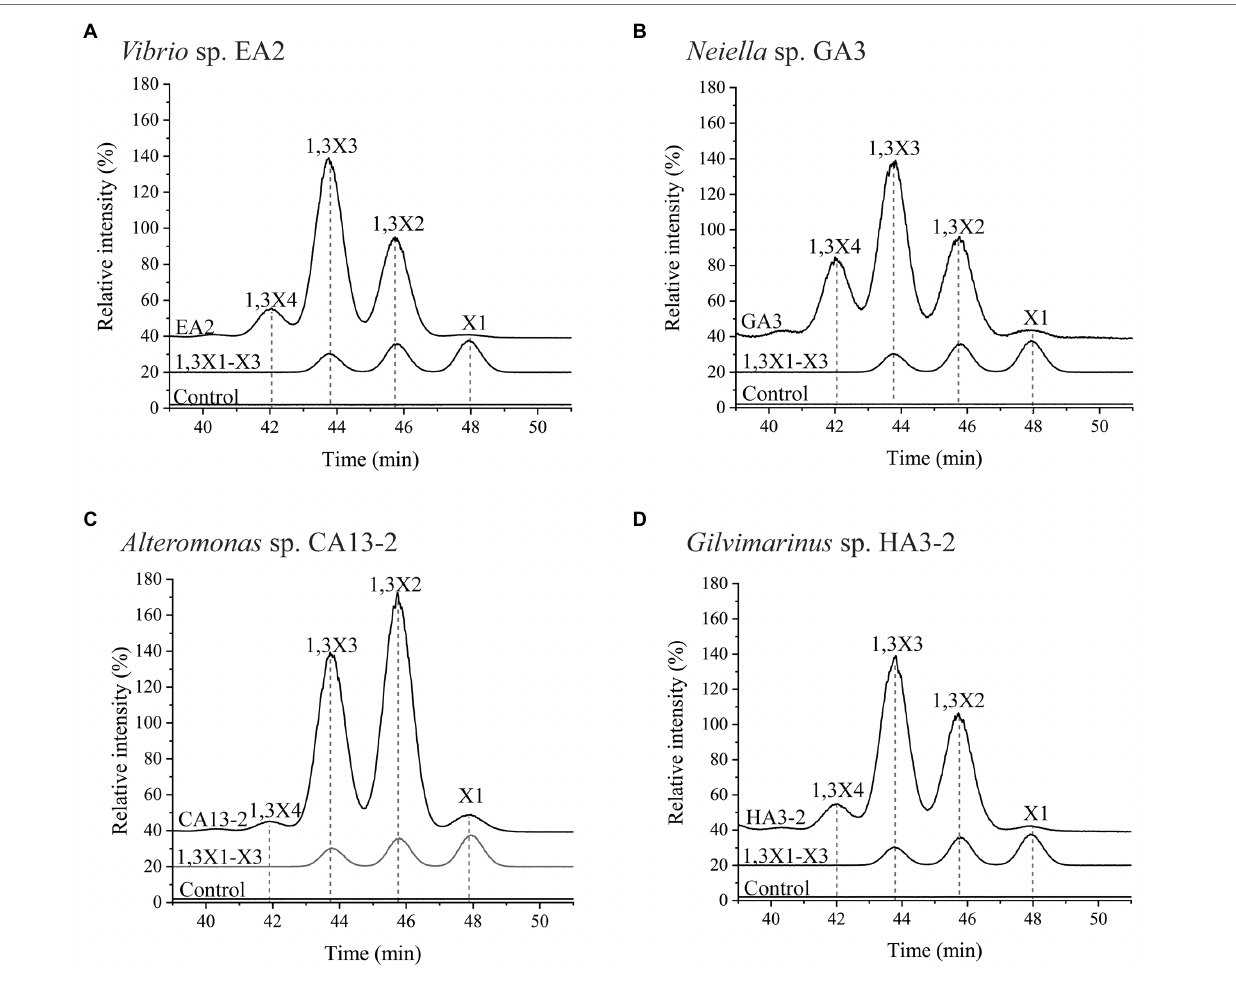
FIGURE 5 | The products released from 1,3-xylan by the hydrolysis of the extracellular 1,3-xylanases secreted by Vibrio sp. EA2 (A) , Neiella sp. GA3 (B) , Alteromonas sp. CA13-2 (C) , and Gilvimarinus sp. HA3-2 (D) . Extracellular 1,3-xylanases from each strain were incubated with 1,3-xylan at 30 ° C for 24 h. Then, the products were analyzed by HPLC-ELSD. The intensity of the 1,3-xylotriose in each chromatogram was normalized as 100%. The reaction system without 1,3-xylanases was used as the control. The data are representative of the results of triplicate